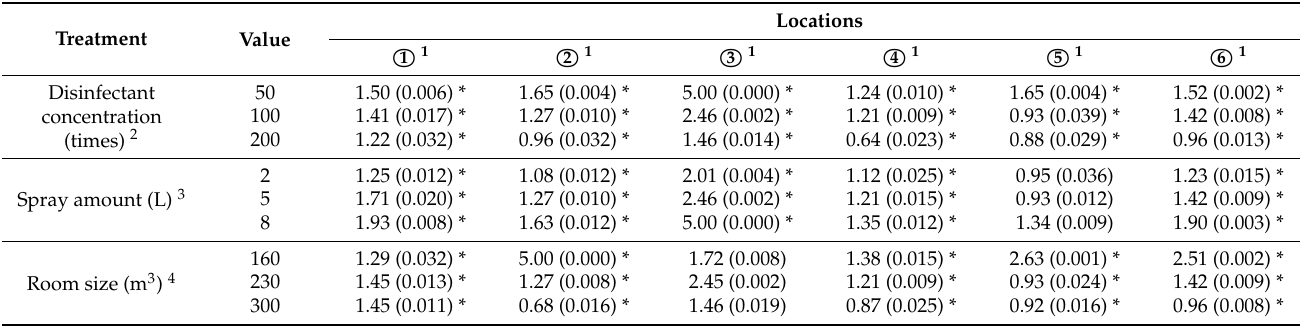
Table 1. Disinfection efficiency (log 10 units) and standard deviation for total bacteria on indoor surfaces by the single treatment of disinfectant concentration, spray amount, and room size.